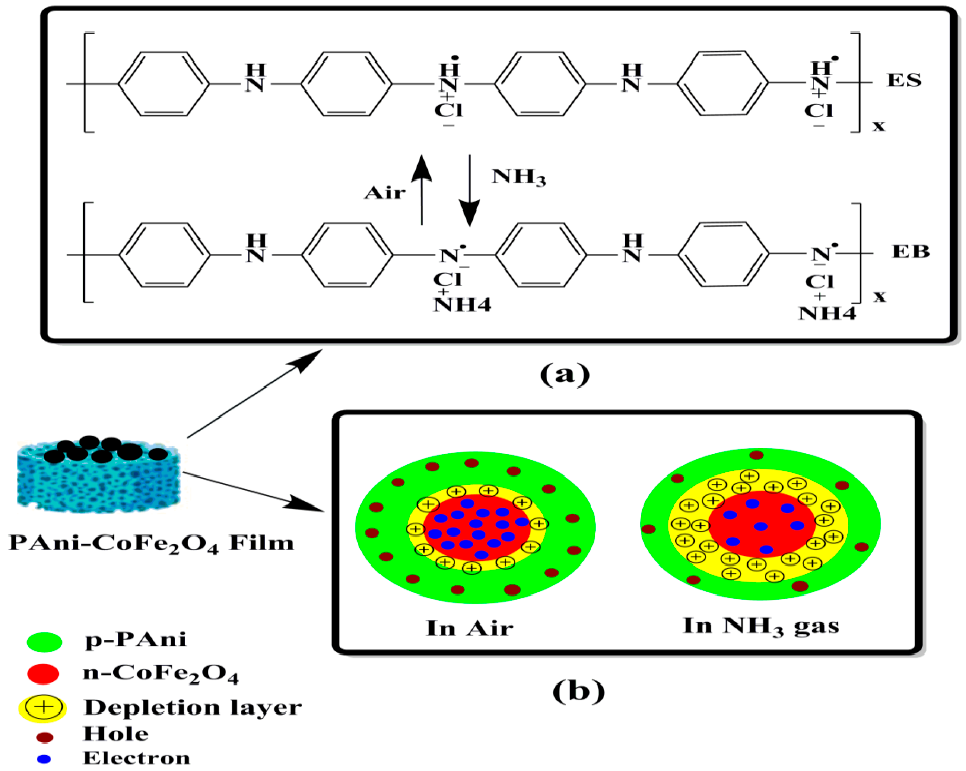
Figure 14. Schematic sensing model of PAni-CoFe 2 O 4 flexible sensor, ( a ) the NH 3 gas interaction with the PAni emeraldine salt, and ( b ) the depletion region changes of PET-PAni-CoFe 2 O 4 in air and NH 3 gas.